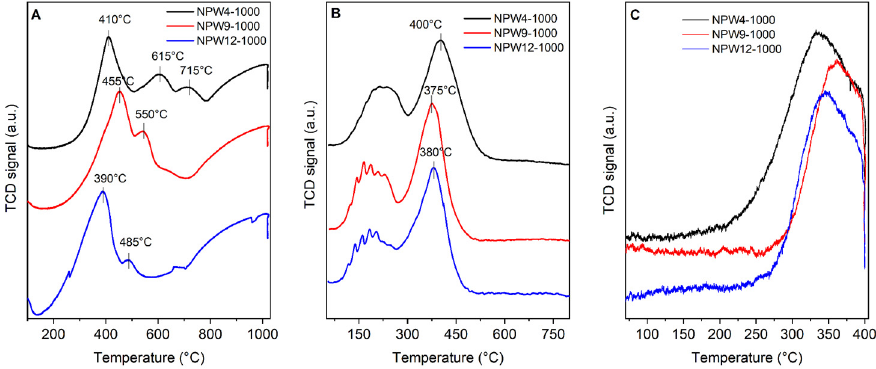
Figure 3. TPR ( a ), TPO ( b ) and TPD ( c ) profiles of NPW4-1000, NPW9-1000, and NPW12-1000